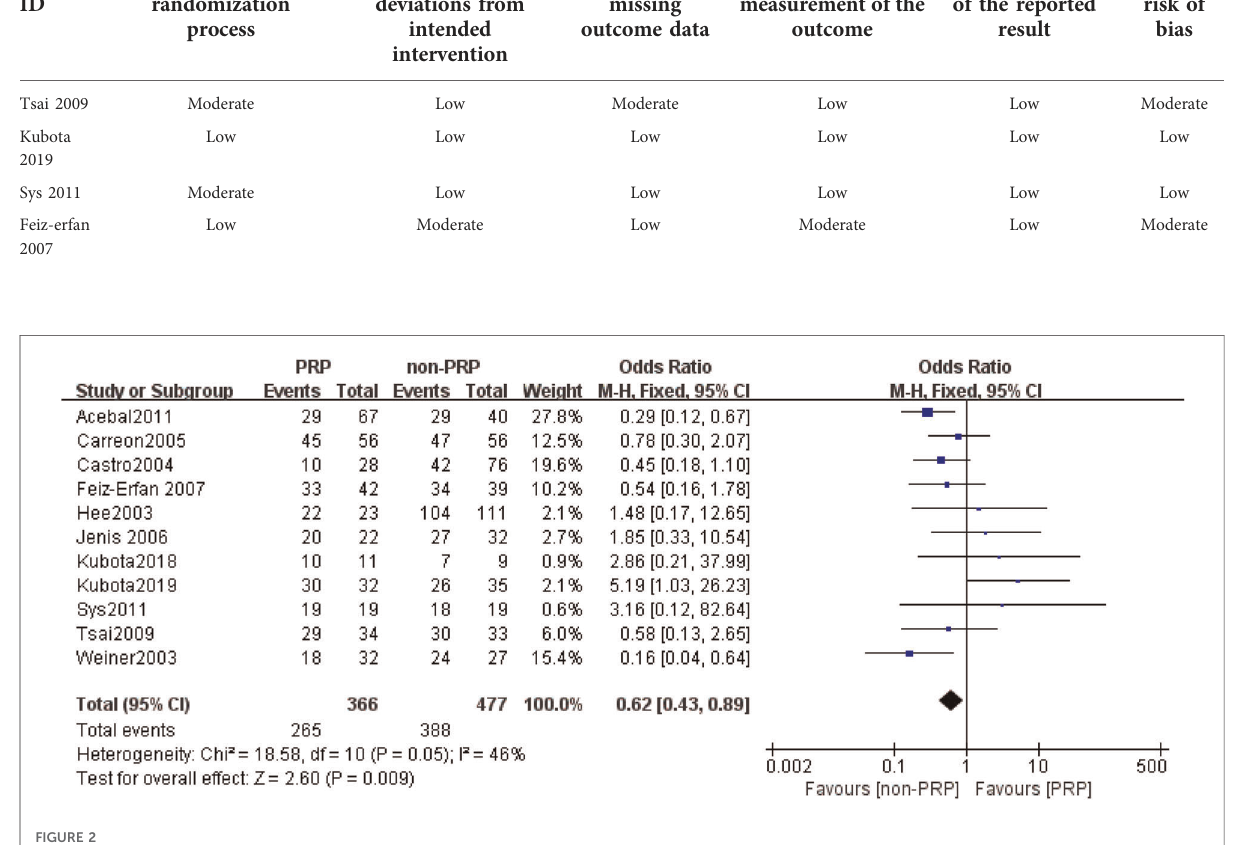
TABLE 5 The risk of bias in randomized trials using the revised cochrane risk of bias tool (RoB-2). Study